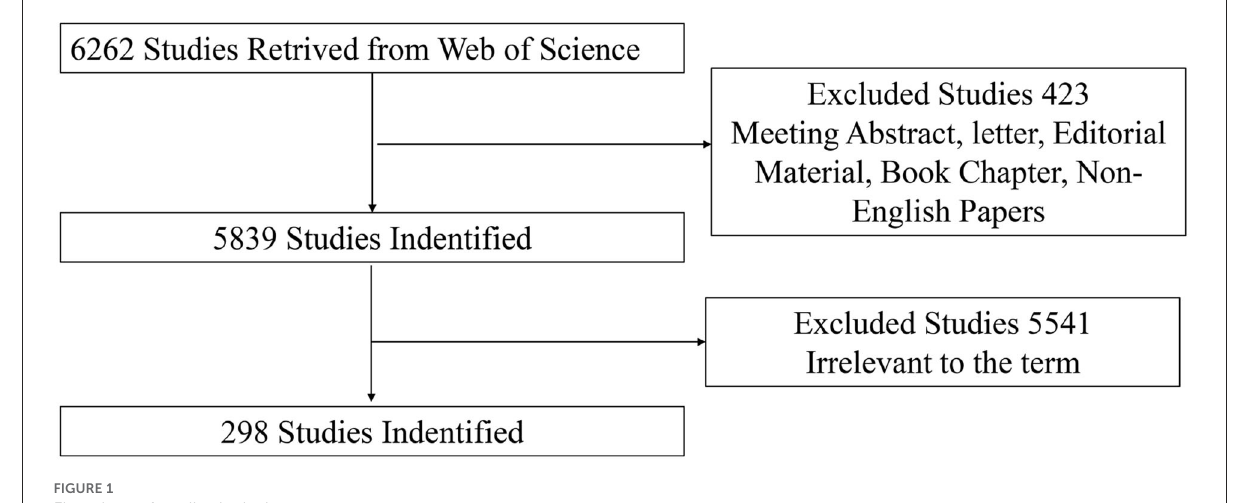
FIGURE1 Flowchart of studies